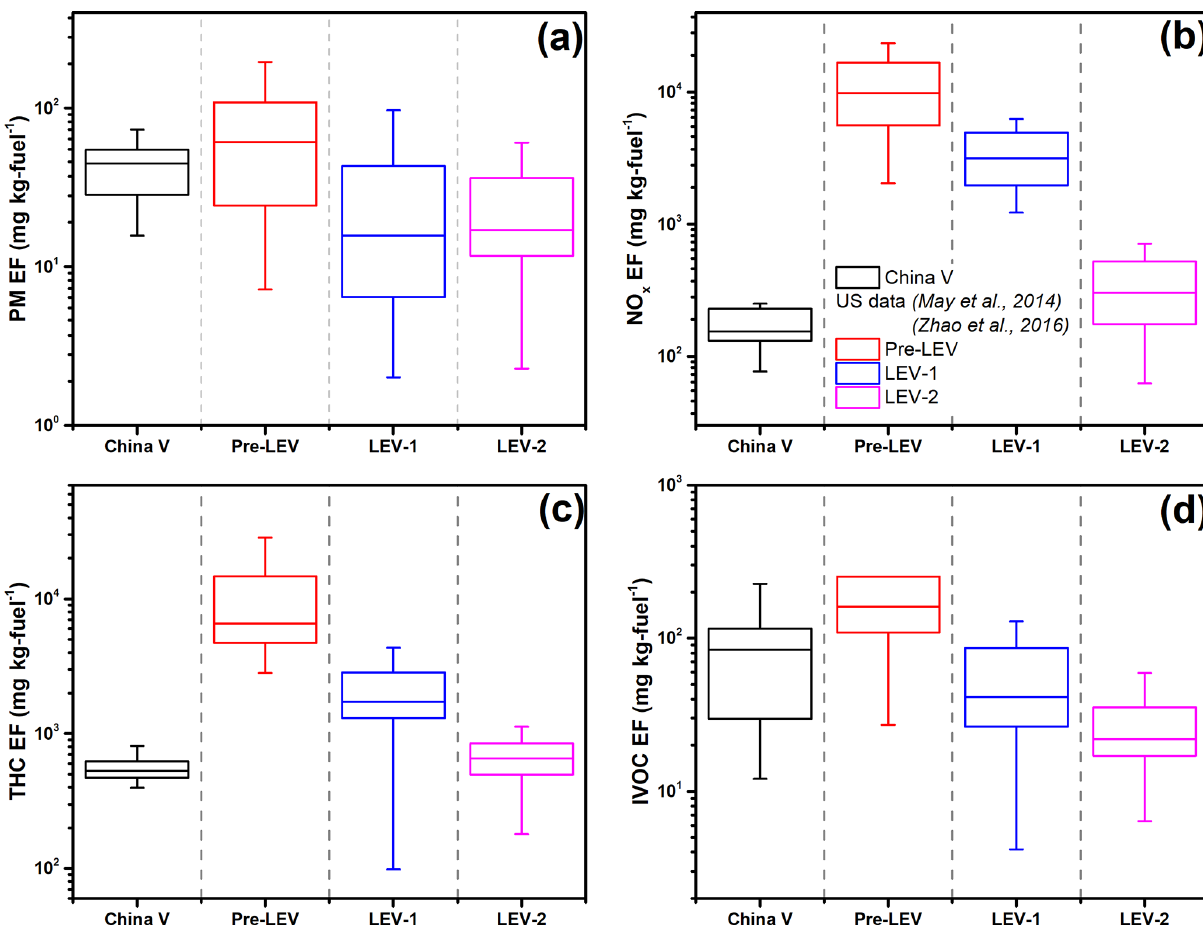
Figure 4. Comparison of emission factors of (a) PM (particulate matter), (b) NO x , (c) THC and (d) IVOC between Chinese and US on-road gasoline vehicles (Zhao et al., 2016; May et al., 2014). The boxes present the 75th and 25th percentiles with the centerline being the median. The US vehicles are grouped by the model year; i.e., pre-LEV refers to vehicles manufactured prior to 1994; LEV-1 represents vehicles from 1994 to 2003; and LEV-2 is vehicles manufactured from 2004 to